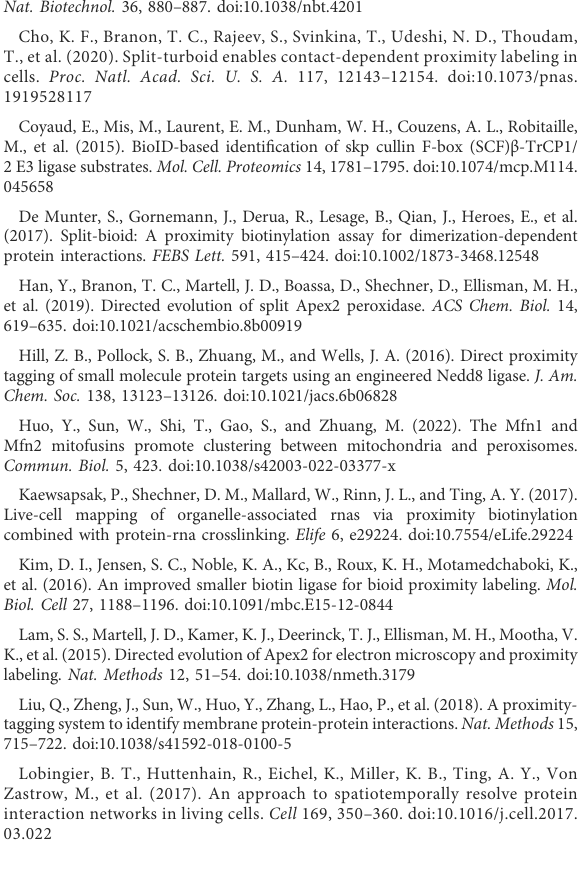
SUPPLEMENTARY FIGURE S1 PUP-IT2 has less non-speci fi c labeling. In vitro Pup modi fi cation assay of PUP-IT2 PEX3 . 10 µM His-PEX19 or BSA were used for the reaction. Proteins were analyzed with SDS-PAGE for Coomassie stain and western blotting, using anti-PEX3 and anti-PEX19